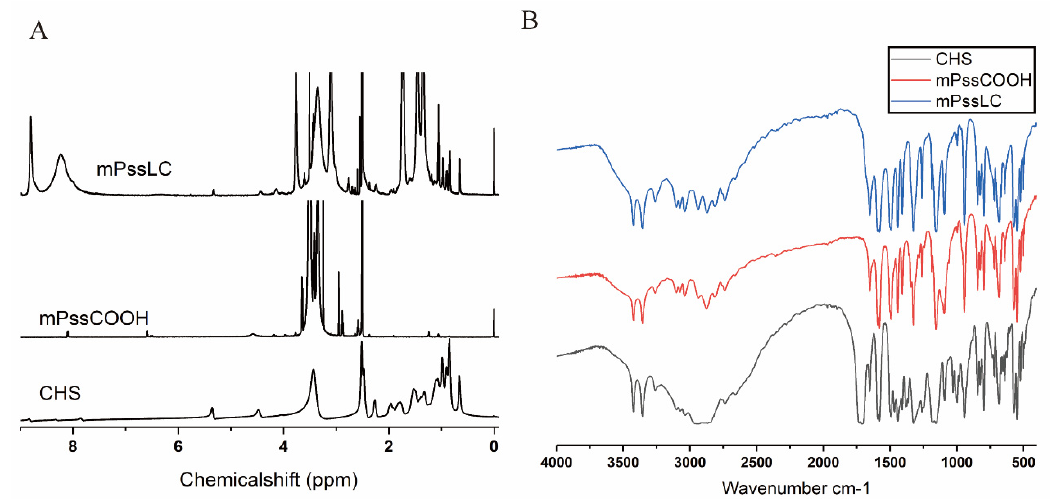
Figure 1. Characterization of CHS, mPssCOOH, and mPssLC. The synthesis of the material was verified by 1H NMR ( A ) and FTIR ( B ).